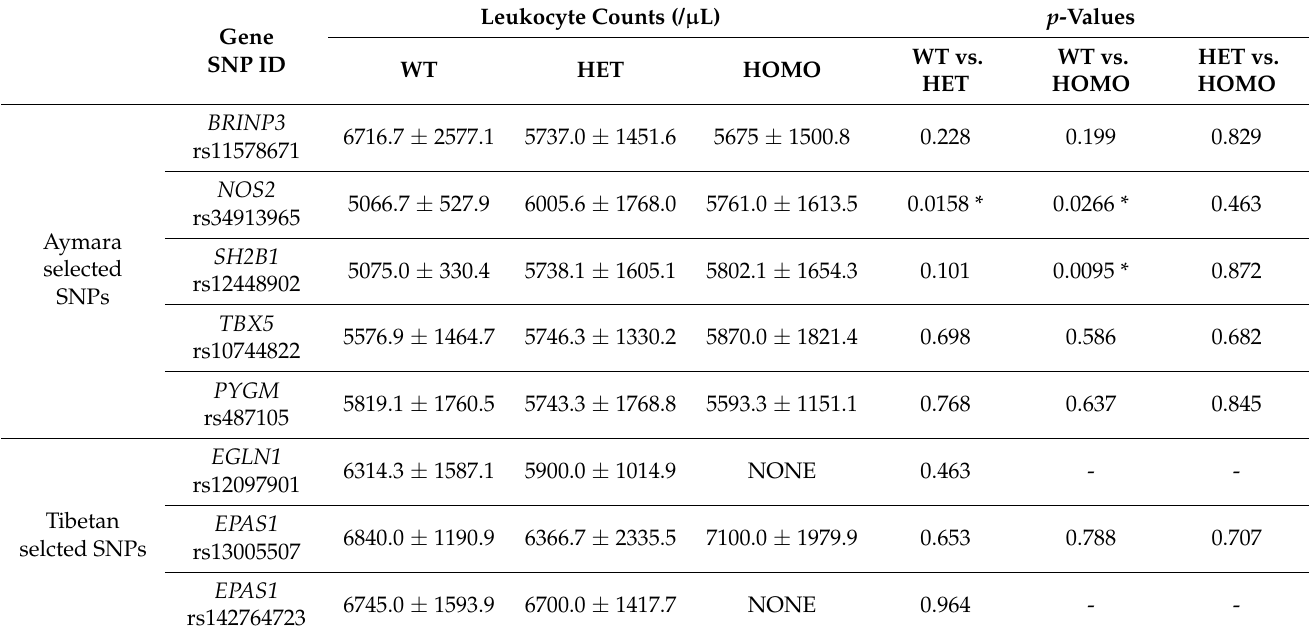
Table 4. Correlation of genotypes to whole blood cell